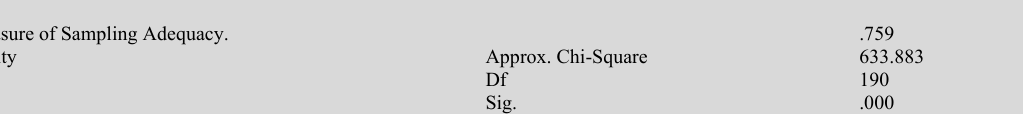
KMO and Bartlett's Test Kaiser-Meyer-Olkin Measure of Sampling Adequacy.